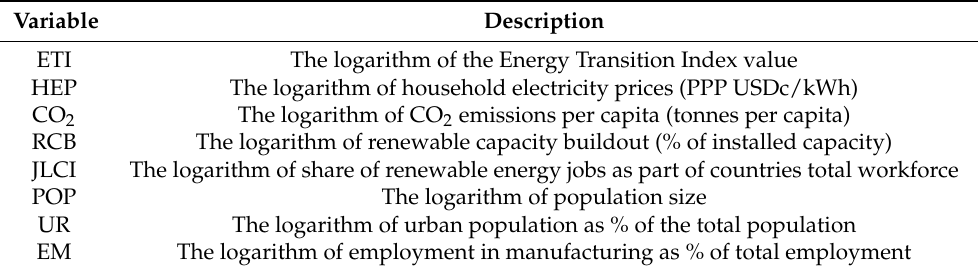
Table 1. Variables used in the